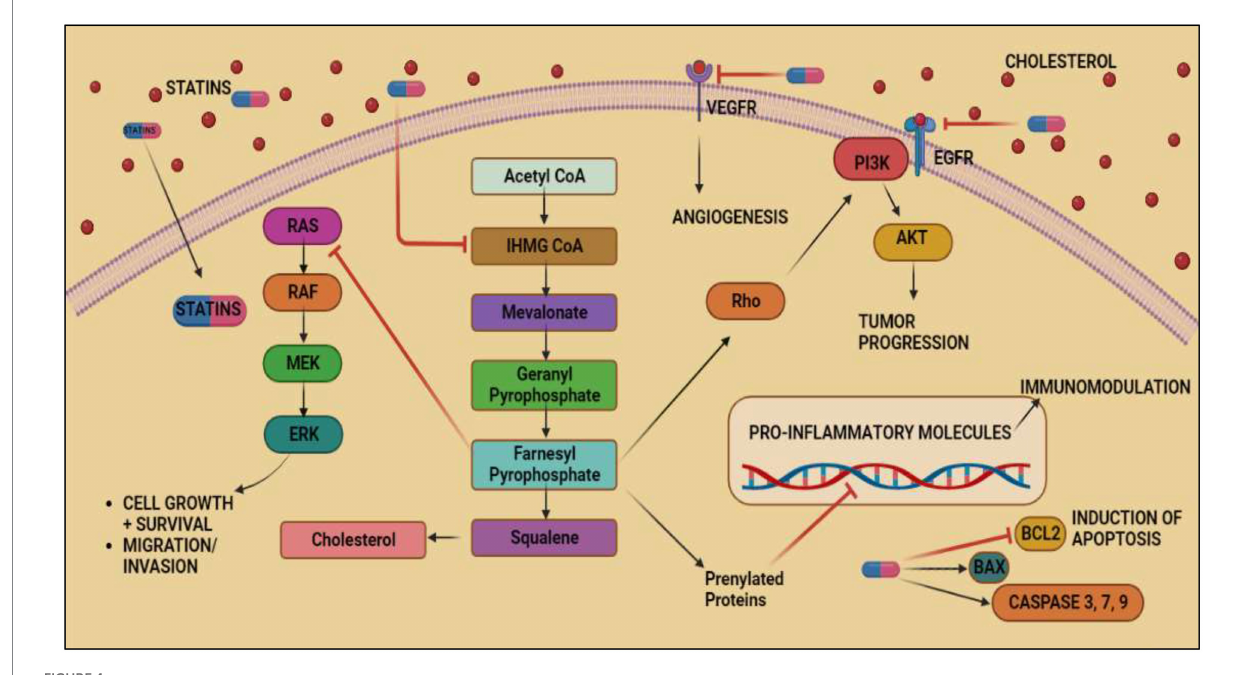
FIGURE 4 Anticancer effects exerted by Statins by inhibiting mevalonate pathway. Acetyl-CoA, the byproduct of glycolysis, is converted into mevalonate, IPP, GPP, FPP, GGPP, and cholesterol through a series of enzymatic processes that make up the mevalonate pathway. FPP and GGPP may both be supplemented to proteins post-translationally, particularly minor monomeric GTPases such as Ras predominantly part of MAPK/ERK pathway responsible for inducing VEGF expression in colorectal cancer. The inhibitory effect of FPP on MAPK/ERK pathway and inhibition of mevalonate pathway by statins causes tumor cell death and prevents migration of tumor cells. Statins shows its inhibitory effect on VEGFR and EGFR thus, inhibiting angiogenesis and tumor progression in cancer. It also inhibits BCL2 and induces aoptosis of cancerous cells.